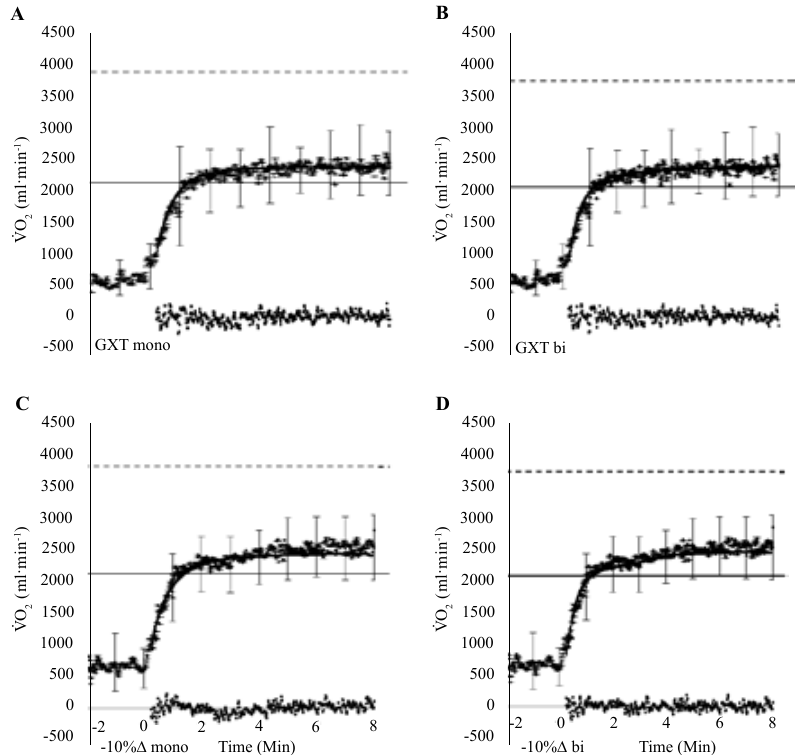
Figure 2. The breath-by-breath oxygen uptake response, mono and bi exponential model fits and residuals across exercise intensity domains in one typical participant. Data from the exercise performed at GET and +10%∆ are displayed. The V̇ O